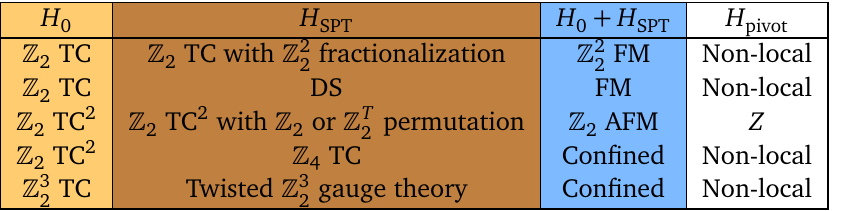
SPT. For each row in the 2 ( H + H ) + J ≈ 0.21. The H where J c J c 0 2 2